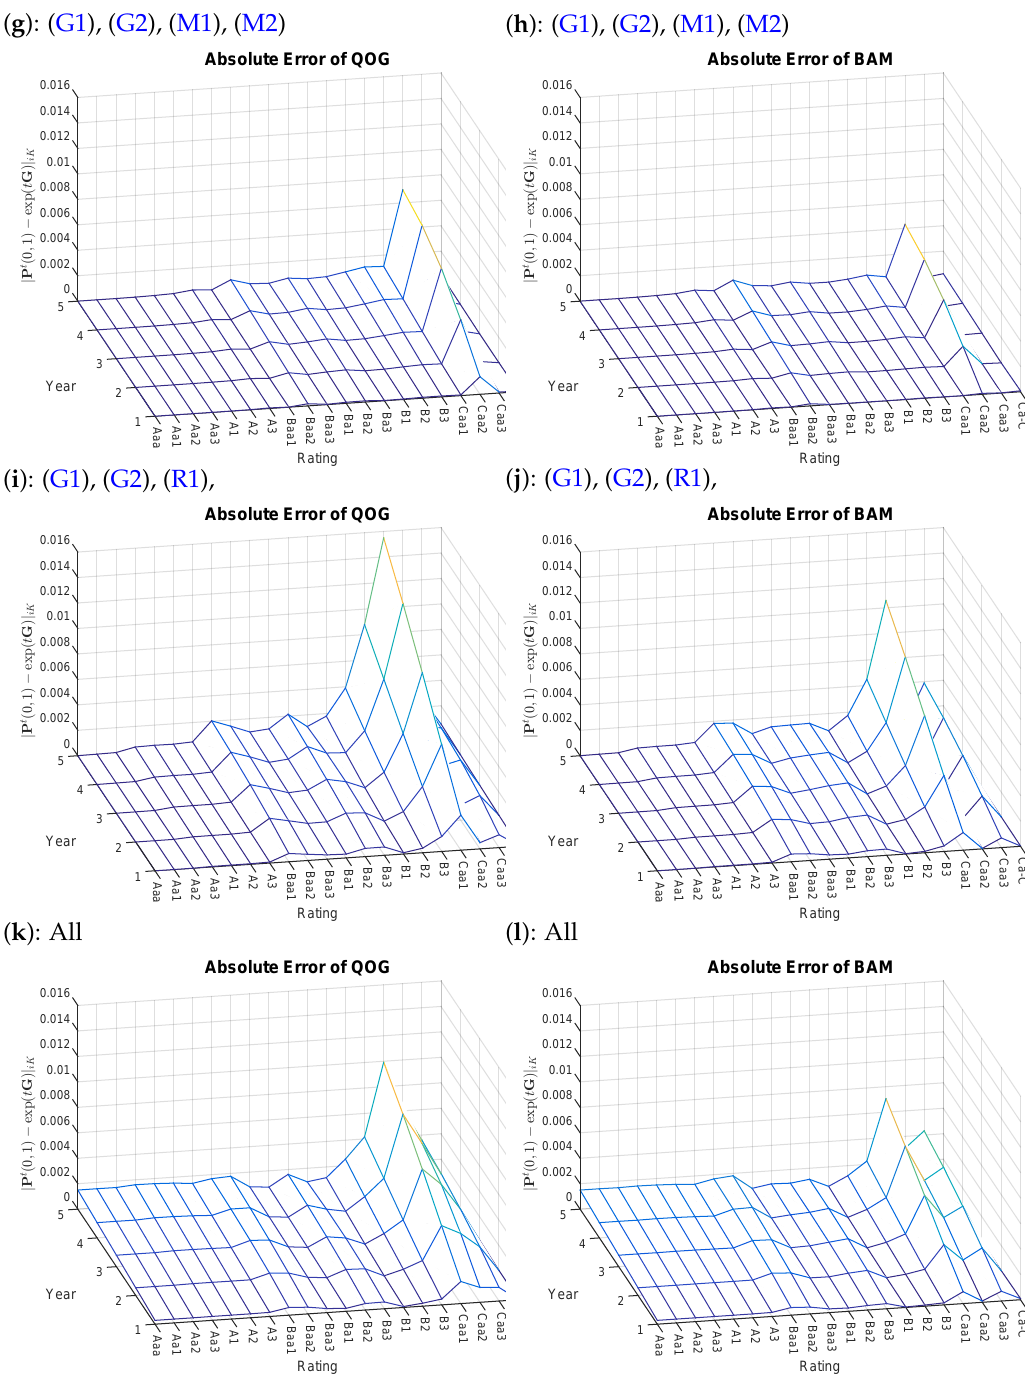
Figure 3. Absolute errors of Problems QOG and BAM based on various additional constraints with starting point X DMPG , for transition matrix P Moodys XXL ( 0,1 ) in Table A1. Left side: ( g , i , k ) QOG; right 0 side: ( h , j , l )